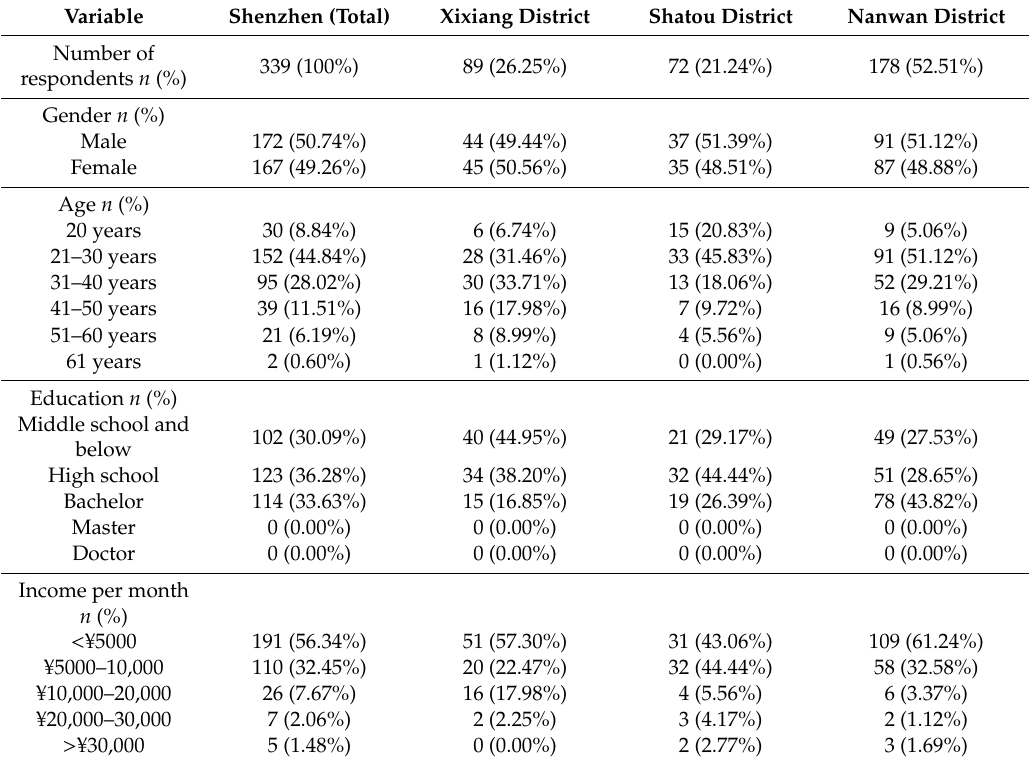
Table 2. The Socio-demographic variables of the